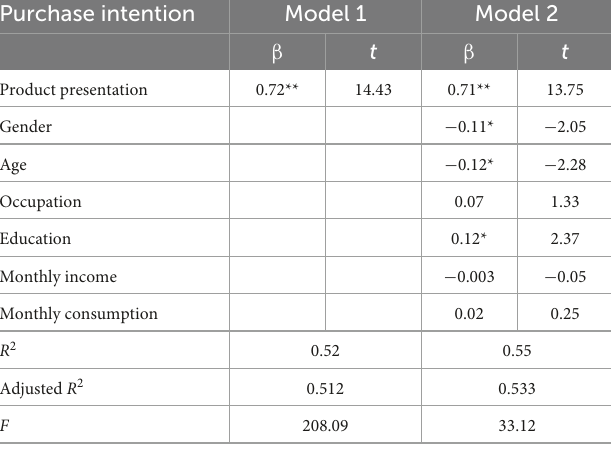
TABLE 3 Regression analysis for Study